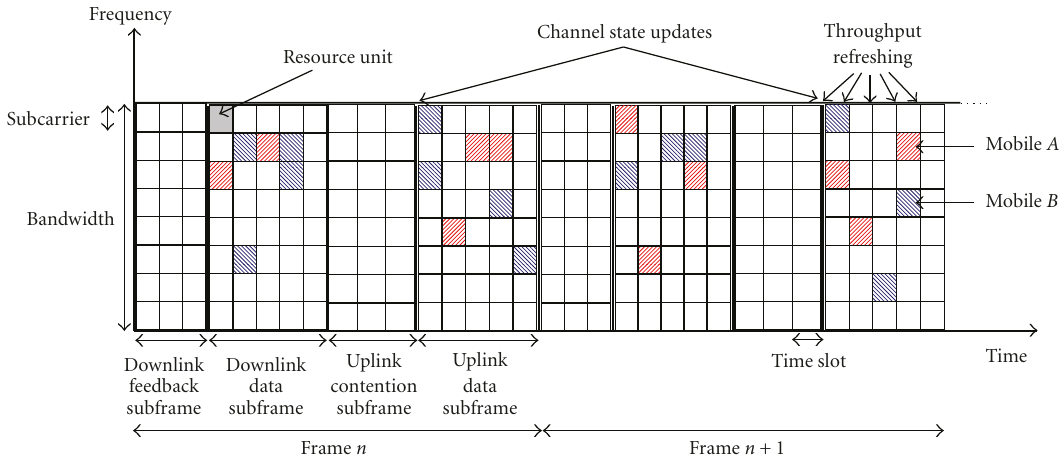
Figure 3: WFO frame structure in TDD